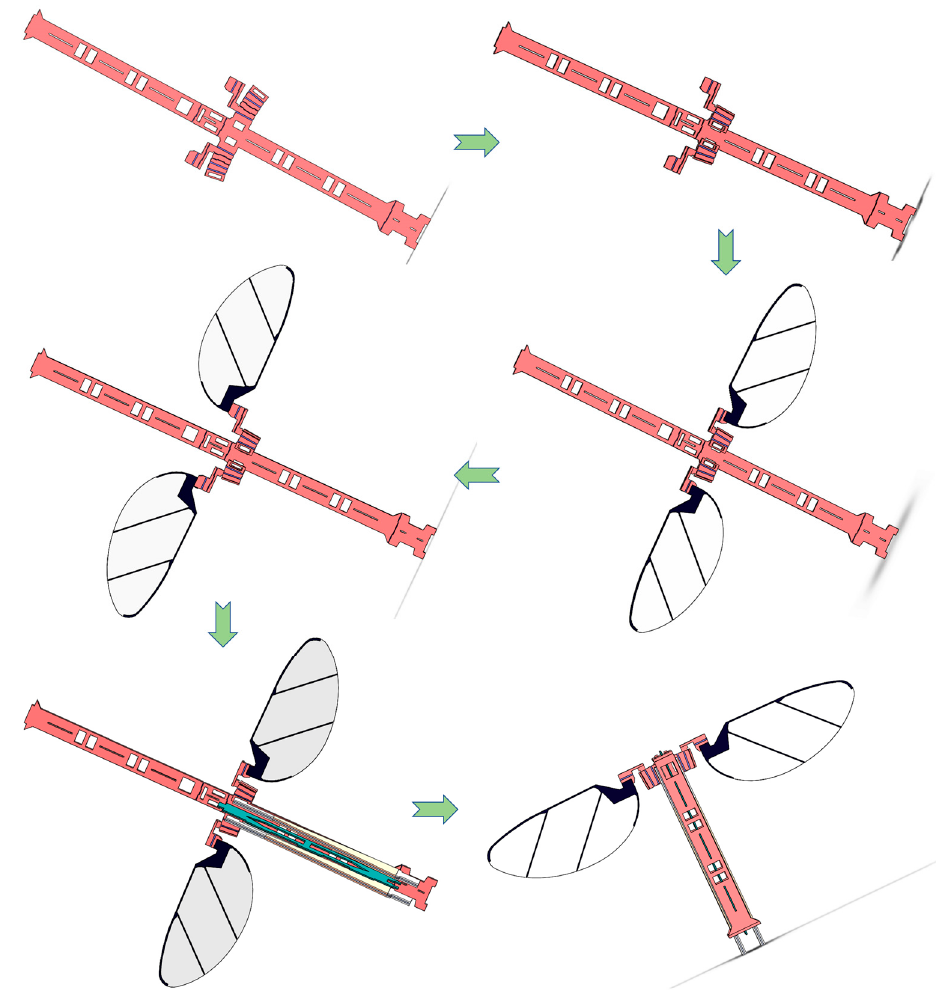
Figure 8. The complete assembly process of integrated manufacturing of flapping ‐ wing air vehicles.